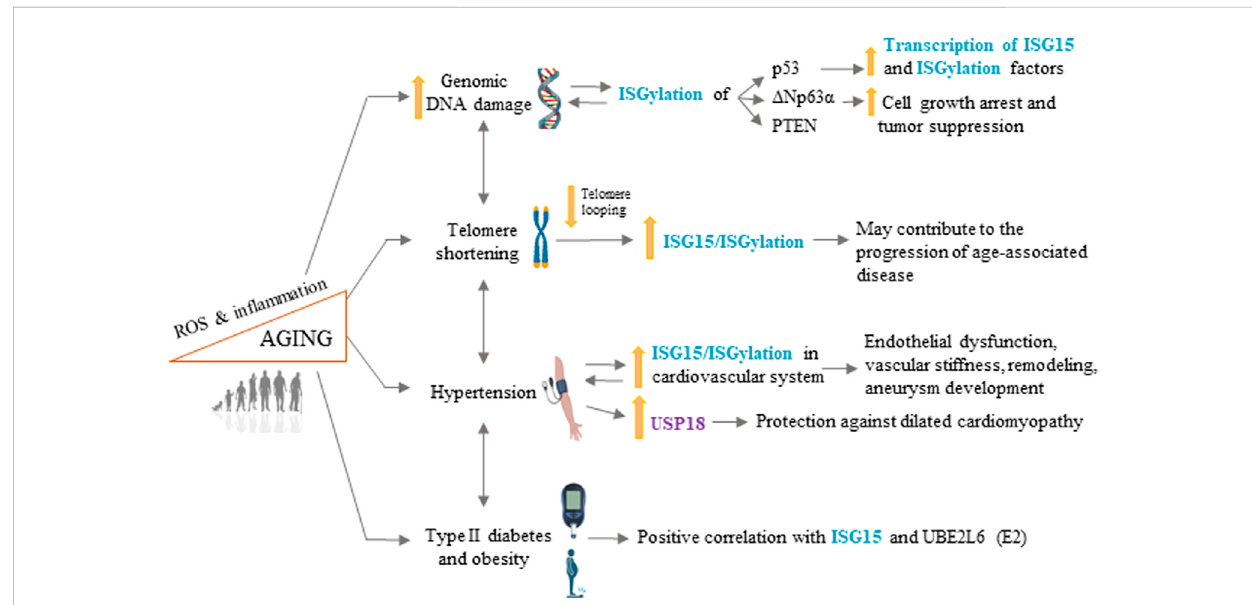
FIGURE 2 ISG15 in longevity and age-related cardiovascular disease. ISG15 is associated with several processes involved in aging and age-related cardiovascular disease, including increased genomic DNA damage, telomere shortening, hypertension, type II diabetes, and obesity. ROS, reactive oxygen species. Some illustrations were created using